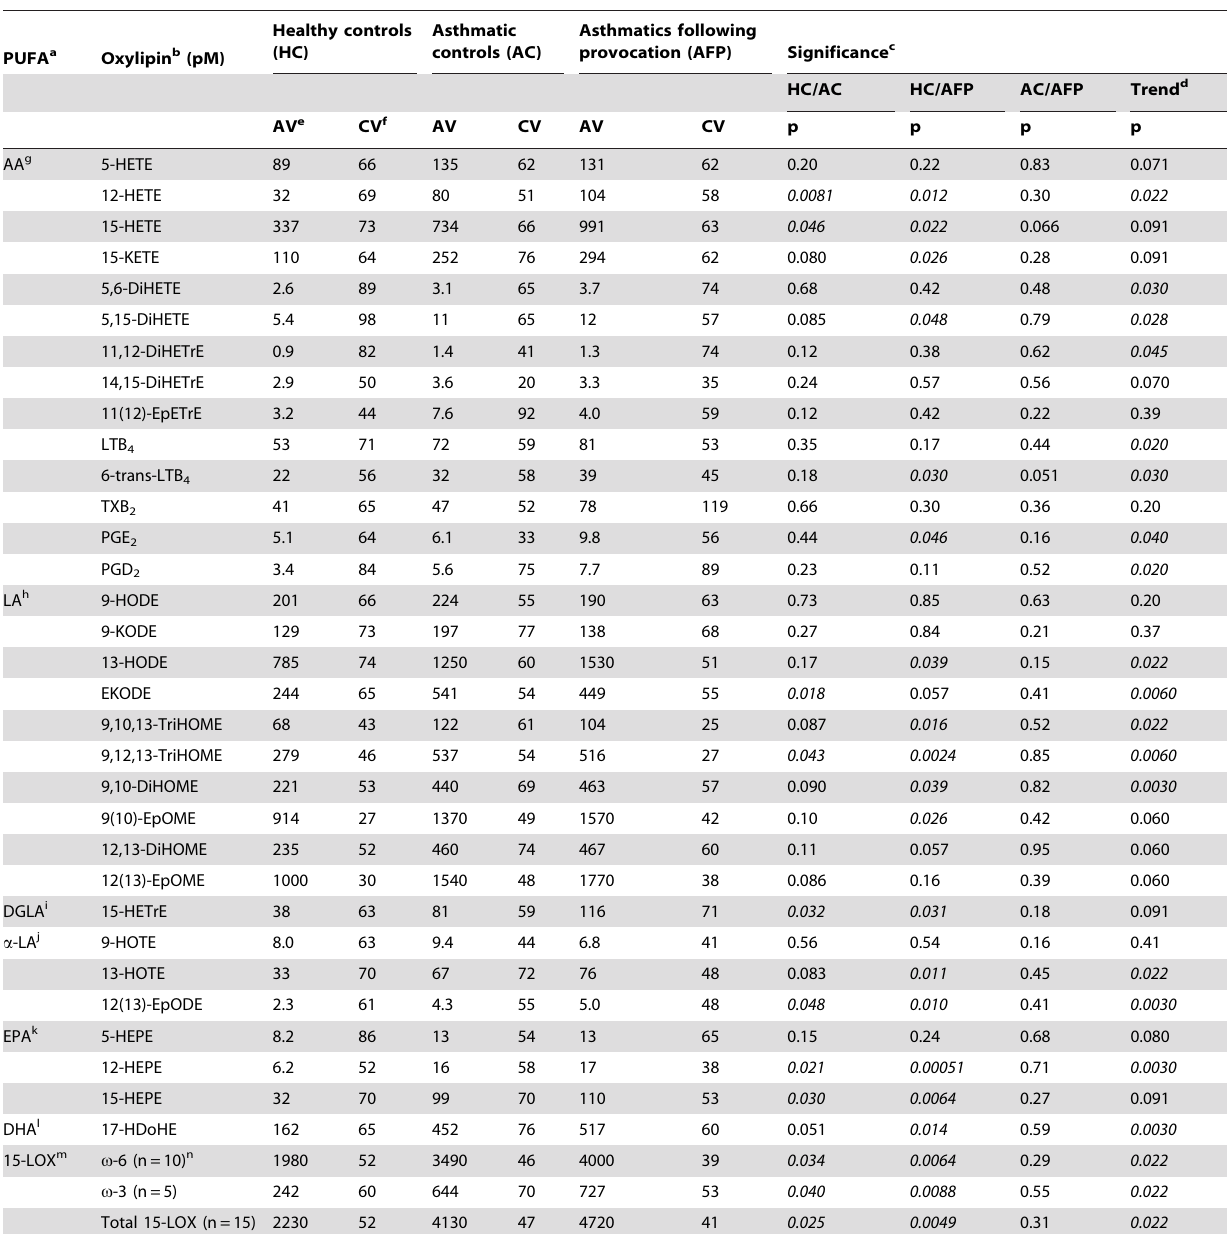
Table 2. Oxylipin concentrations in BALF from 1) Healthy controls 2) Asthmatic controls and 3) Asthmatics following provocation.